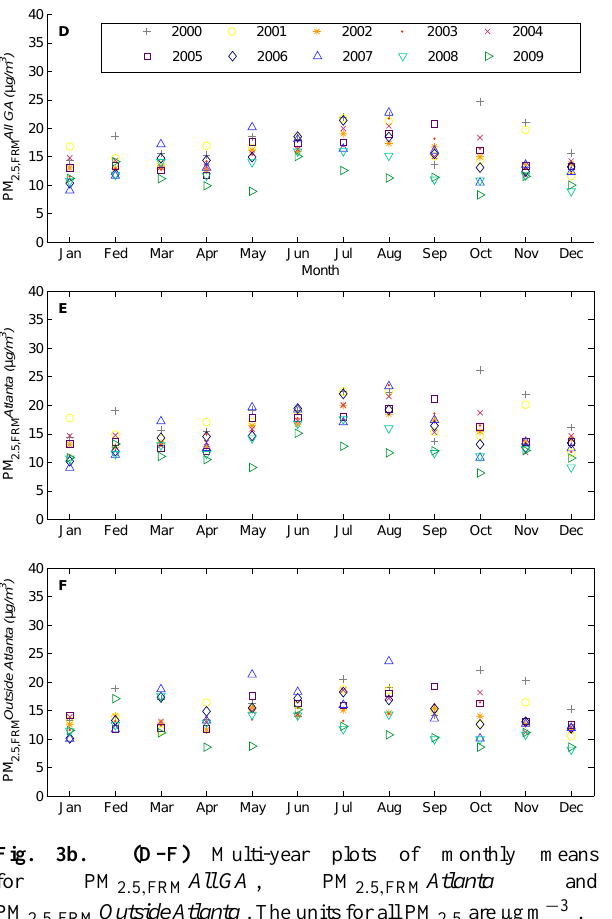
Fig. 3b. (D–F) Multi-year plots of monthly means for PM 2 . 5 , FRM AllGA , PM 2 . 5 , FRM Atlanta and PM 2 . 5 , FRM OutsideAtlanta . The units for all PM 2 . 5 are µgm − 3 .